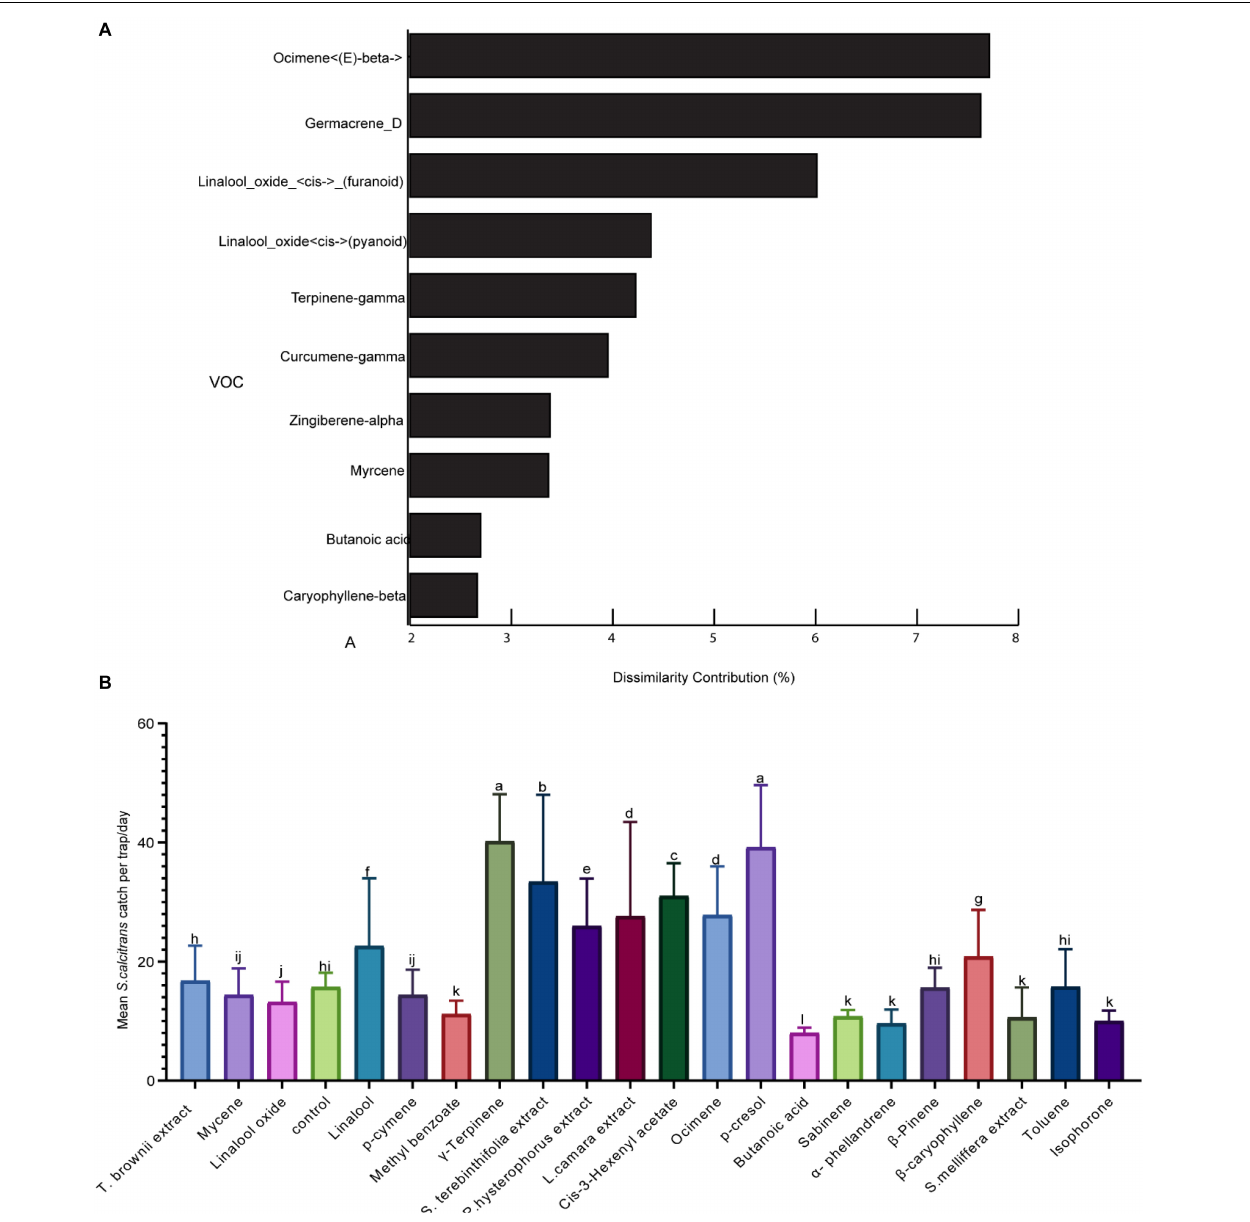
FIGURE 4 | Representation of the 10 most plant-indicative volatile organic compounds (VOCs) across the plant species and field evaluation of their attractivity (A) . Similarity percentage analysis and the percent contribution of the predominant compounds for the dissimilarity between the six plant species. (B) Graph showing the mean stable flies caught using various VOCs. Bars followed by different letters are statistically different ( p < 0.05).